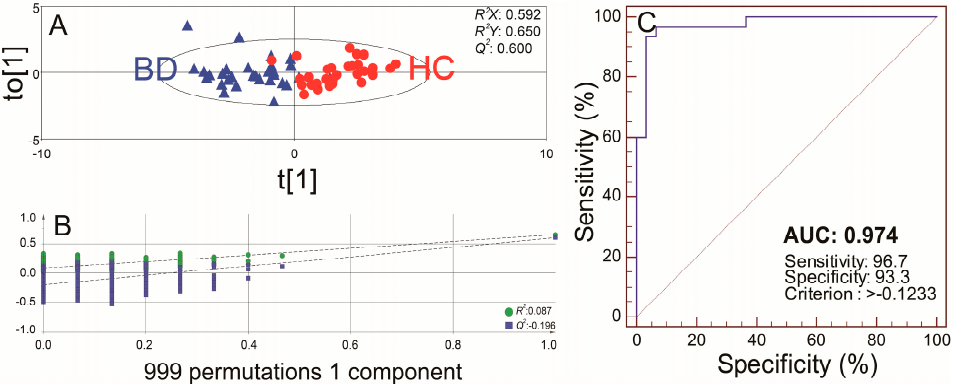
Figure 3. The score plot of the orthogonal partial least squared-discrimination analysis (OPLS-DA) ( A ), and a receiver-operating characteristic (ROC) curve of the model ( B ) in the discovery set based on 10 potential metabolic biomarkers. The numbers represent the sample numbers. In the OPLS-DA model, the blue triangles and red circles denote Behcet’s disease (BD) and healthy controls (HC), respectively. The ROC curve of the model had an AUC of 0.974 and high values of sensitivity (96.7%) and specificity (93.3%) (95% confidence interval 0.896–0.998) ( C ) .